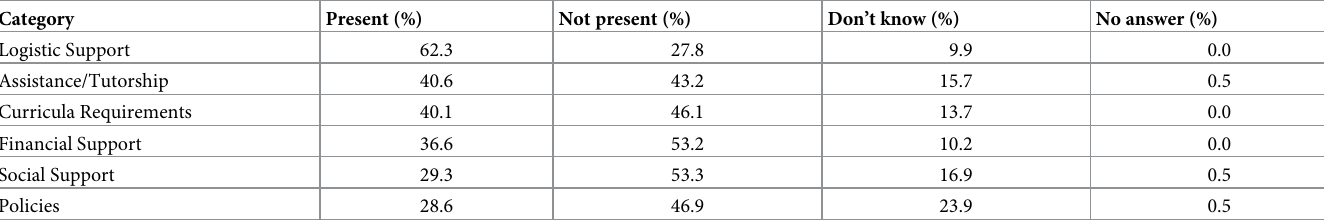
Table 1. Extant dual career policies and provisions at higher education institutes in descending